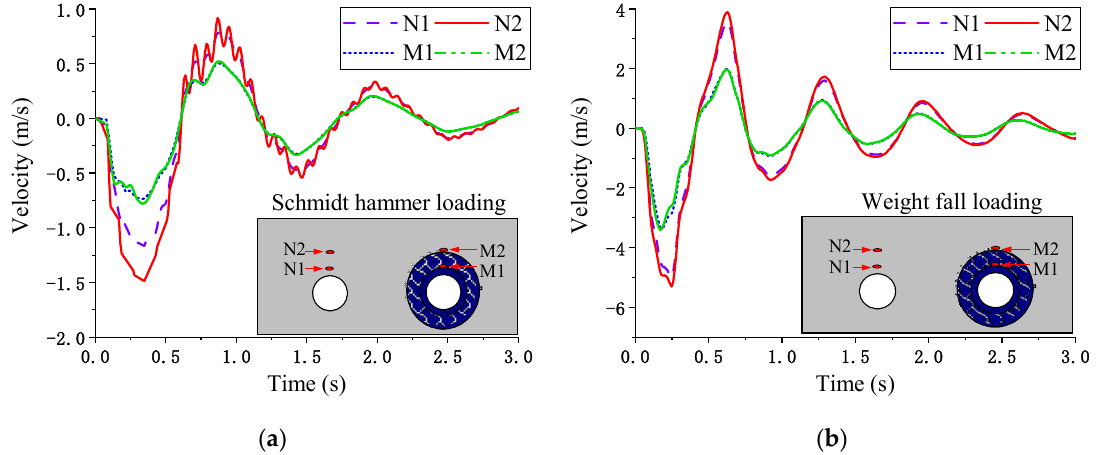
Figure 9. Calculated velocity curves above the coal roadway under ( a ) Schmidt hammer loading and ( b ) weight fall loading.